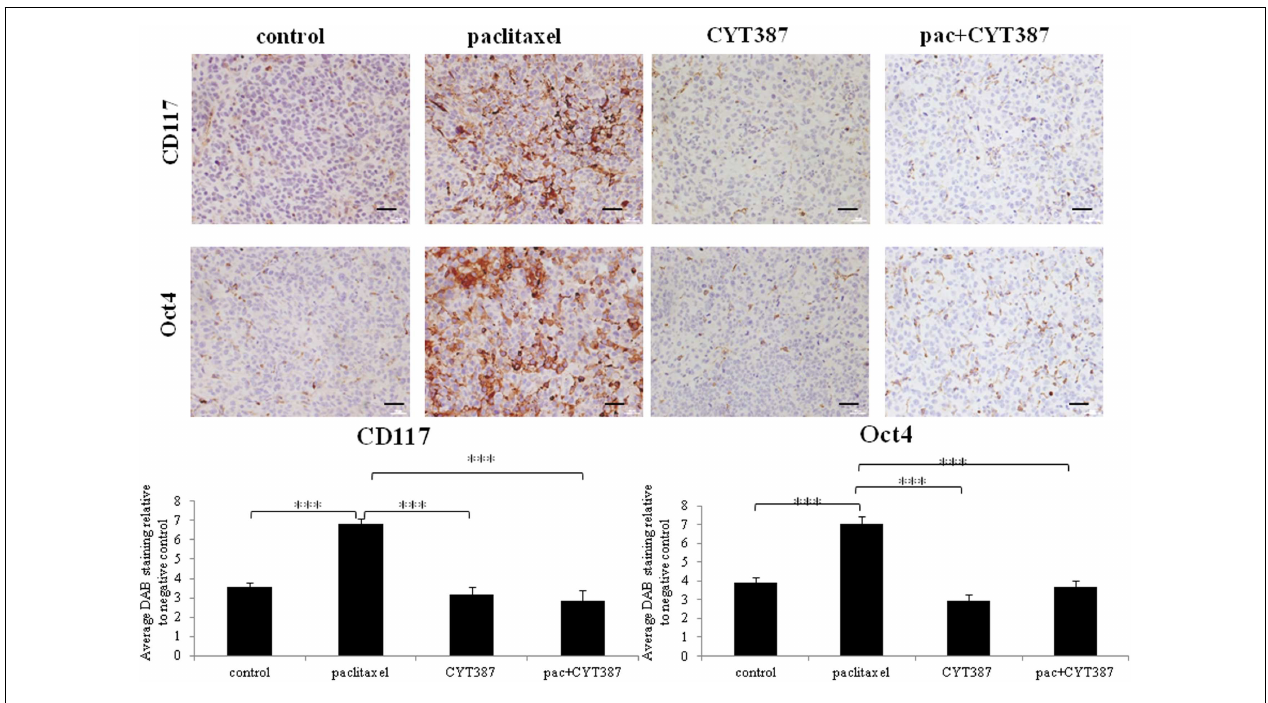
FIGURE 5 | Immunohistochemistry images of CD117 and Oct4 staining in xenografts generated from subcutaneous transplantation of HEY cells into mice administered with or without paclitaxel, CYT387, or pac + CYT387 .Tumor sections were stained with antibodies specific for CD117 and Oct4 as described in the Section “Materials and Methods.” *** p < 0.001.